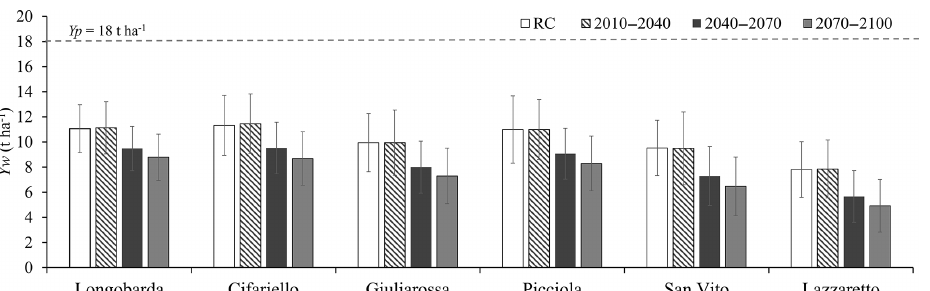
Figure 2. Simulated Yw values for all soil series, considering the reference climate (RC; 1971–2005) and future climate scenarios (RCP 8.5) expressed for three time periods (2010–2040, 2040–2070 and 2070–2100). The Yp (potential yield) is the maize production for the Destra Sele area assuming optimal irrigation and fertilization and no pests and diseases. Yp is only calculated for the reference climate.